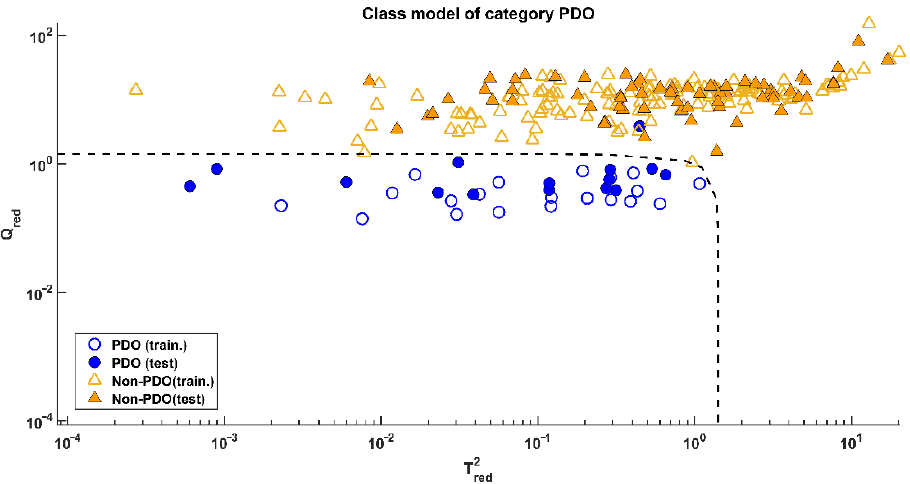
Figure 3. SIMCA: Projection of the samples onto the 𝑄 red vs. 𝑇 red2 model space of class PDO.